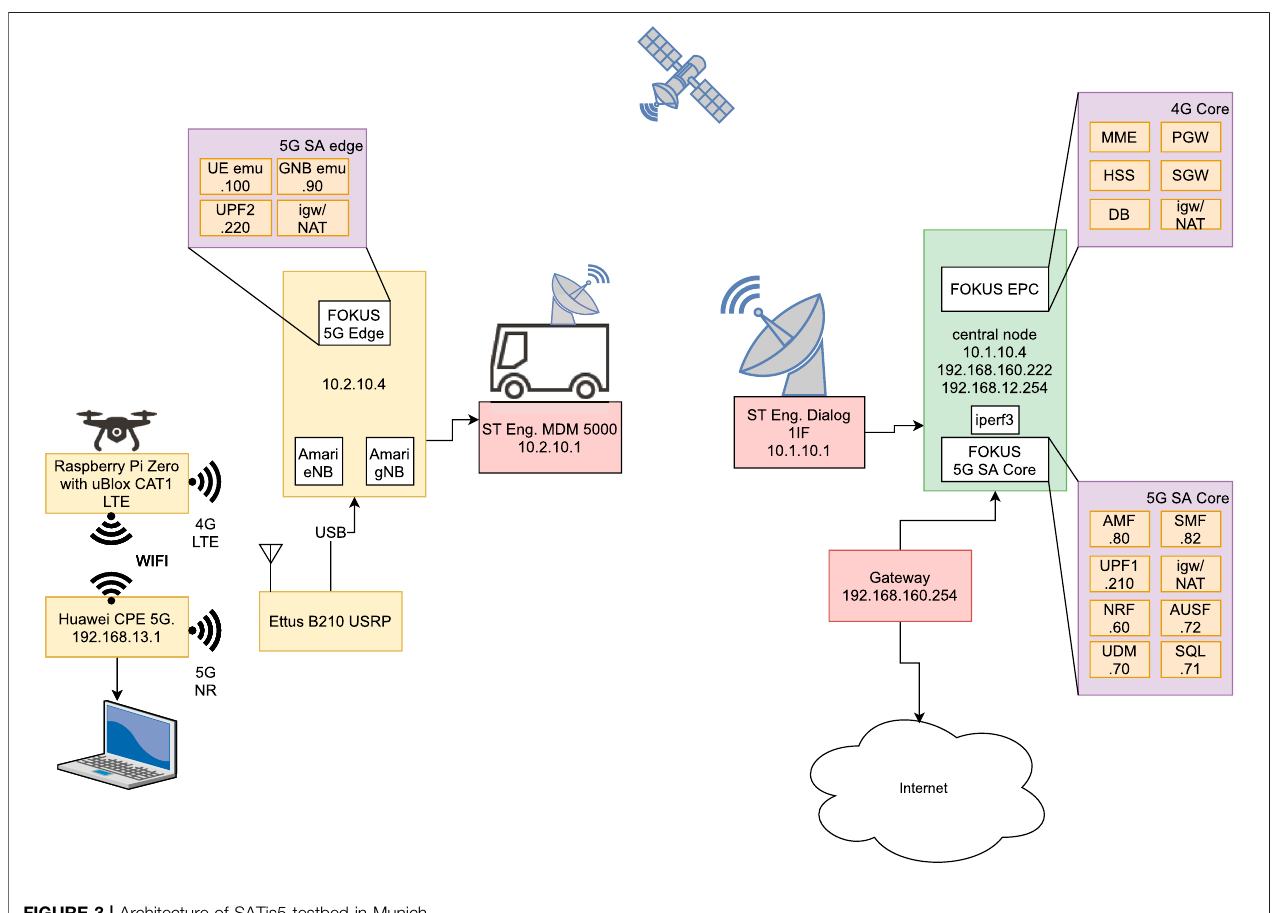
FIGURE 3 | Architecture of SATis5 testbed in Munich.